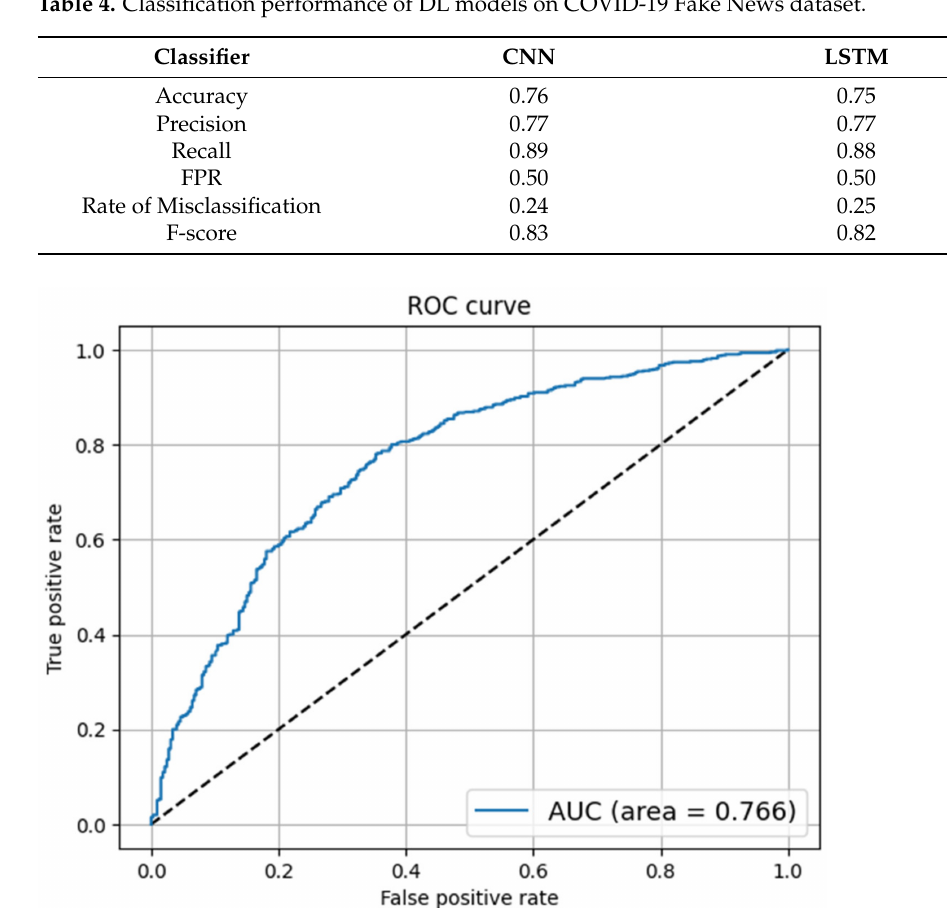
Table 4. Classification performance of DL models on COVID-19 Fake News dataset.